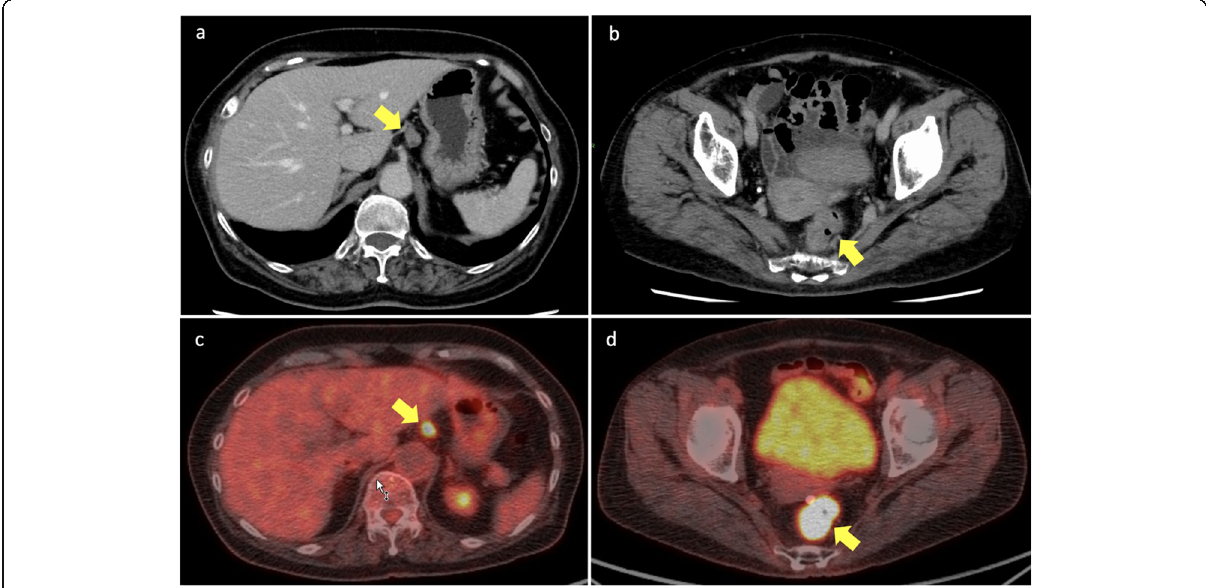
Fig. 2 Computed tomography (CT) and fluorodeoxyglucose positron emission tomography (FDG-PET). a Enhanced upper abdominal CT showing three lymph node swellings in the lesser curvature area of the stomach (arrow). b Enhanced lower abdominal CT revealing rectal cancer invading the serosa (arrow). c Upper abdominal FDG-PET CT showing FDG accumulation in the lesser curvature lymph nodes of the stomach (arrow). d Lower abdominal FDG-PET CT scan revealing FDG accumulation in the main tumor of the rectum